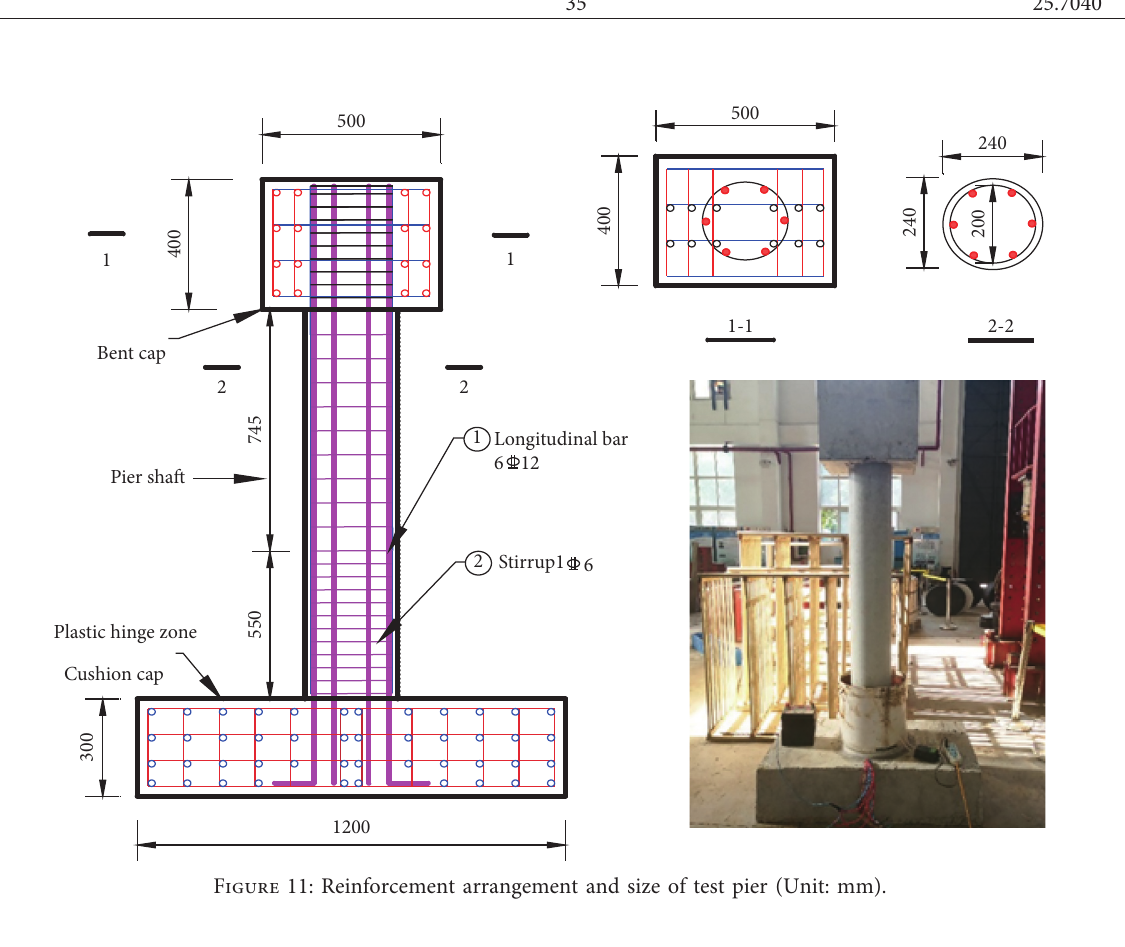
Figure 11: Reinforcement arrangement and size of test pier (Unit: